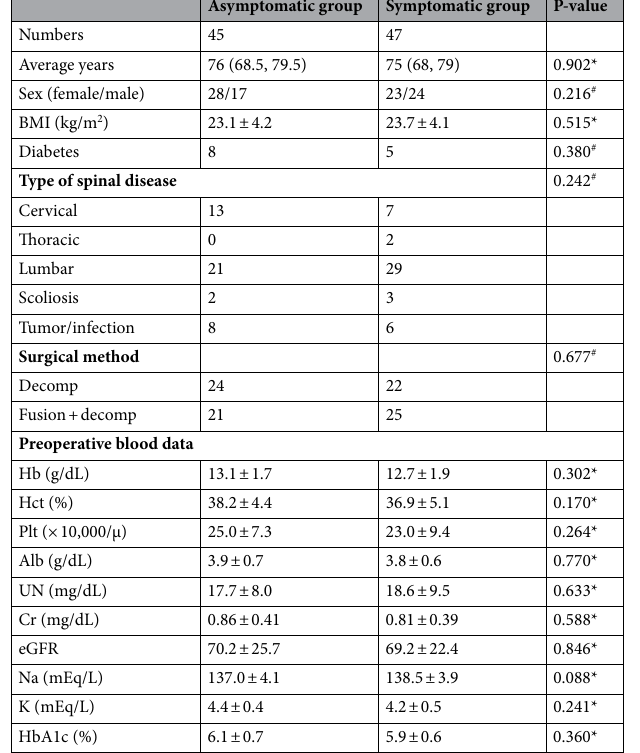
Table 6. Sub-analysis of the factors relating to symptomatic hyponatremia. Continuous variables were represented by their average ± 1.0 standard deviation when showing normal distribution; otherwise, they were represented by medians with 1st and 3rd quartiles. BMI body mass index, Decomp decompression, Alb albumin, Cre creatinine, eGFR estimated glomerular filtration rate, Hb hemoglobin, HbA1c hemoglobin A1c, Hct hematocrit, K potassium, Na sodium, Plt platelet, Postop postoperative, UN urea nitrogen. *Mann– Whitney U test. # Chi-squared